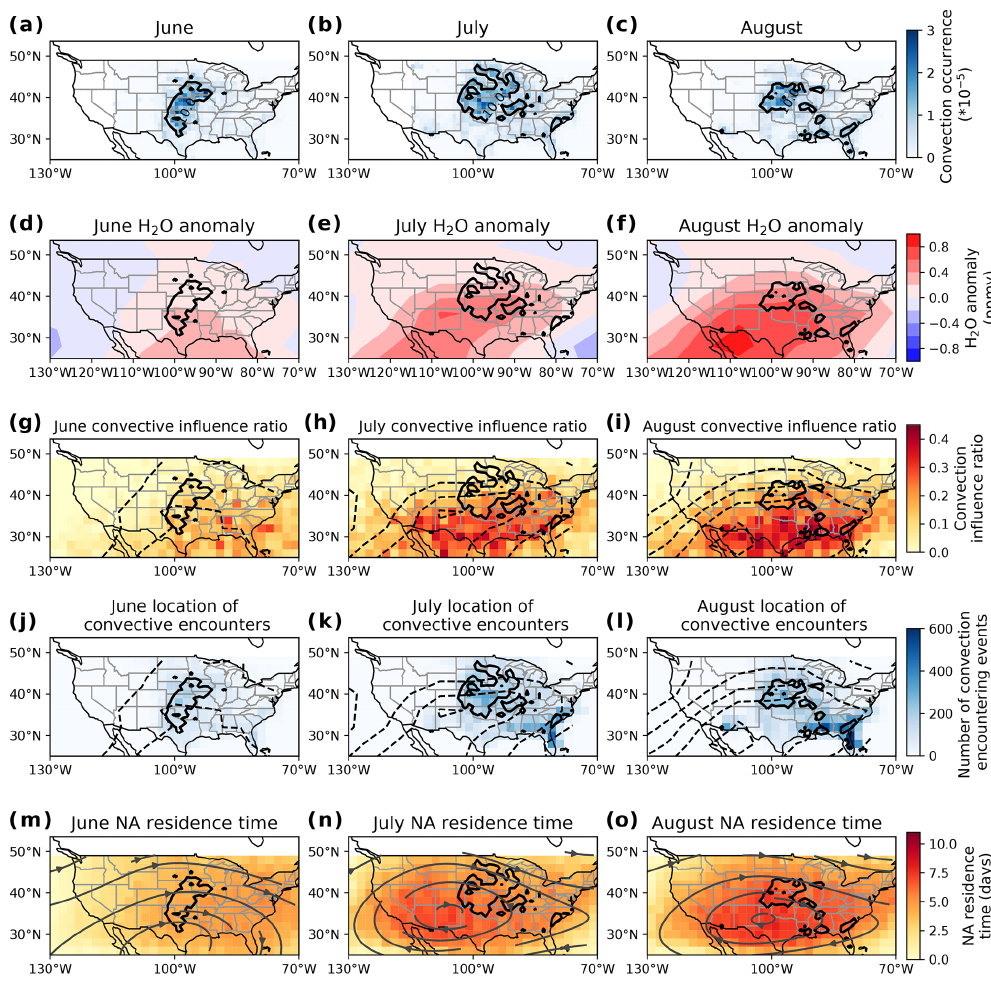
Figure 3. (a–c) Distribution of the 100hPa GridRad deep convection occurrence averaged over 2005–2016 in (a) June, (b) July, and (c) Au- gust. The black contour in each panel (repeated in each row) is the 10 − 5 contour of GridRad convective occurrence, averaged over that month. (d–f) Geographical distribution of the MLS 100hPa water vapor anomaly (after removal of the zonal mean), averaged over 2005–2016 in (d) June, (e) July, and (f) August. (g–i) Geographical distribution of the convection influence ratio over the NA region during (g) June, (h) July, and (i) August 2005–2016. The dashed black contour (repeated in g – l ) is the water vapor anomaly contours matching the shading in the corresponding upper panel. (j–l) Location where convectively influenced parcels encounter convection during 2005–2016 (j) June, (k) July, and (l) August. (m–o) Geographical distribution of the parcel time spent over the NA region during (m) June, (n) July, and (o) Au- gust. The stream lines are horizontal velocities interpolated onto 100hPa using the cubic spline method from ERAi data averaged over the same